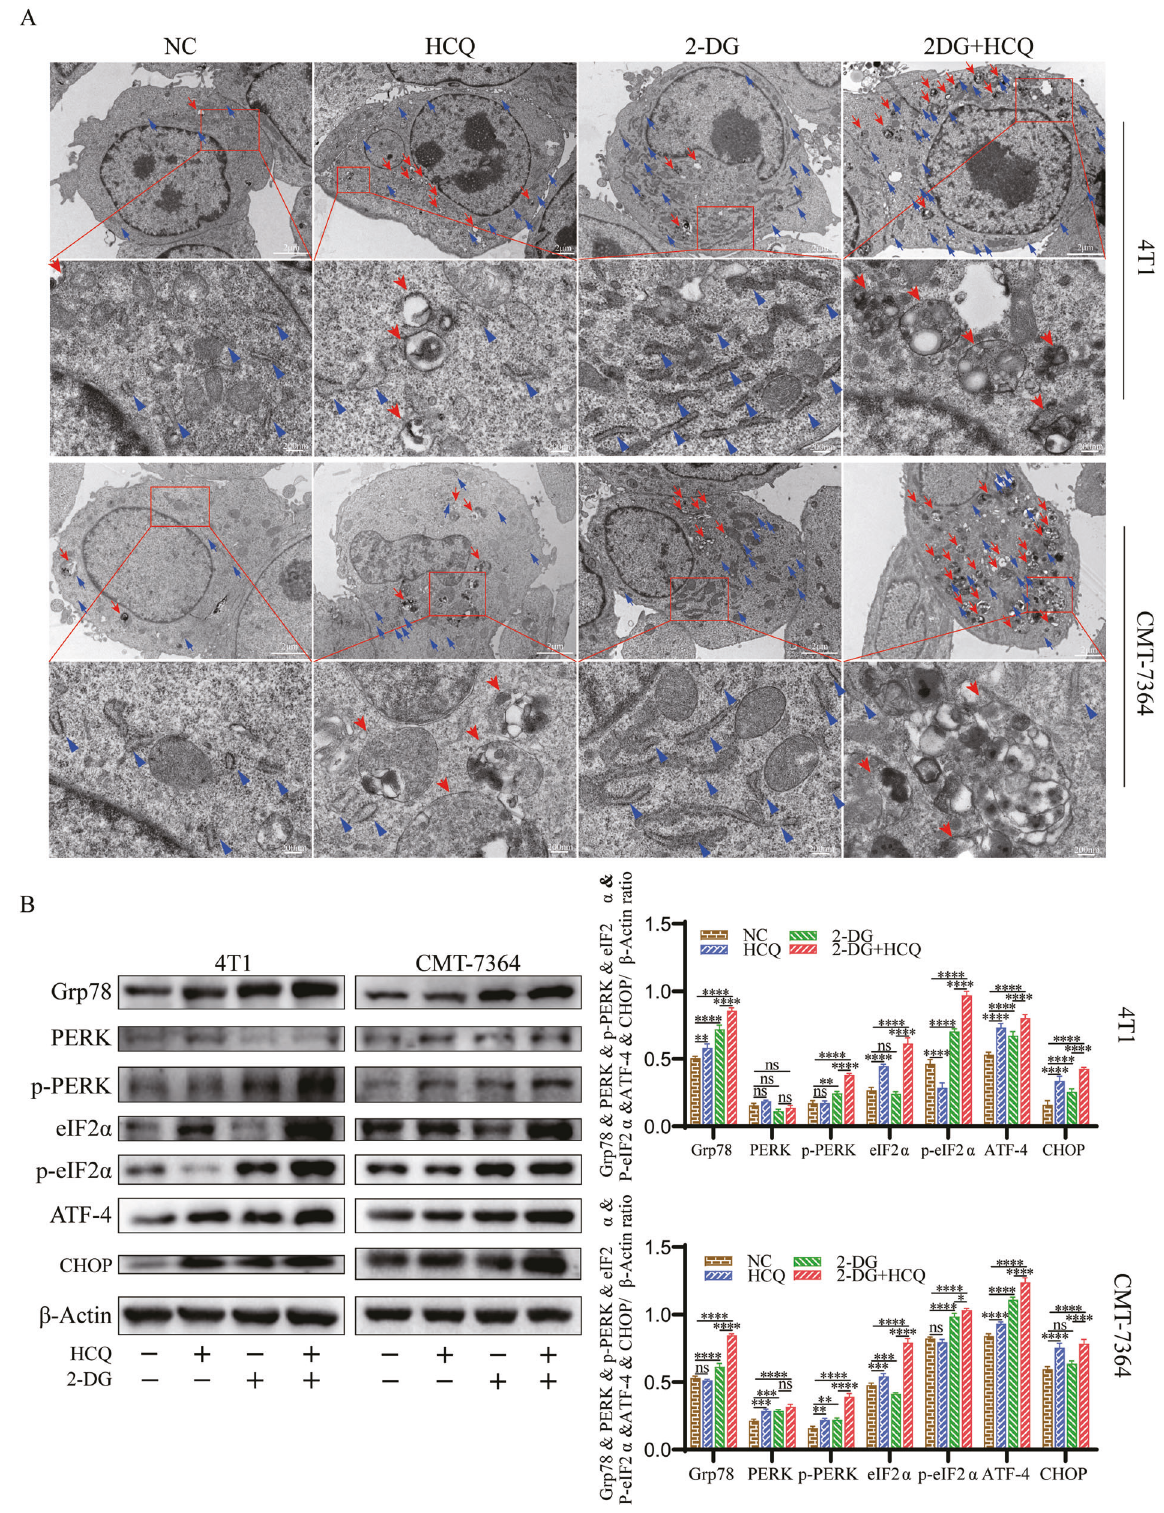
Fig. 4 HCQ and 2-DG synergistically promote endoplasmic reticulum stress through the PERK/eIF2 α /ATF-4 pathway. A Representative TEM images depicting the ultrastructure of 4T1 and CMT-7364 cells treated without or with HCQ, 2-DG or 2-DG combined with HCQ for 24 h. Red arrows indicate autophagic vacuoles; blue arrows indicate endoplasmic reticulum. Scale bars: 2 mm (Thumbnail), 200 nm (Enlarge image). B Western blot analyses of Grp78, PERK, p-PERK, eIF2 α , p-eIF2 α , ATF-4 and CHOP in cells treated with HCQ and 2 ‐ DG alone or in combination for 24 h. β ‐ actin was used as an internal control. Data are represented as mean ± SD from three independent experiments. * p < 0.05, ** p < 0.01, *** p < 0.001, **** p < 0.0001, ns = not signi fi cant ( p ≥ 0.05).